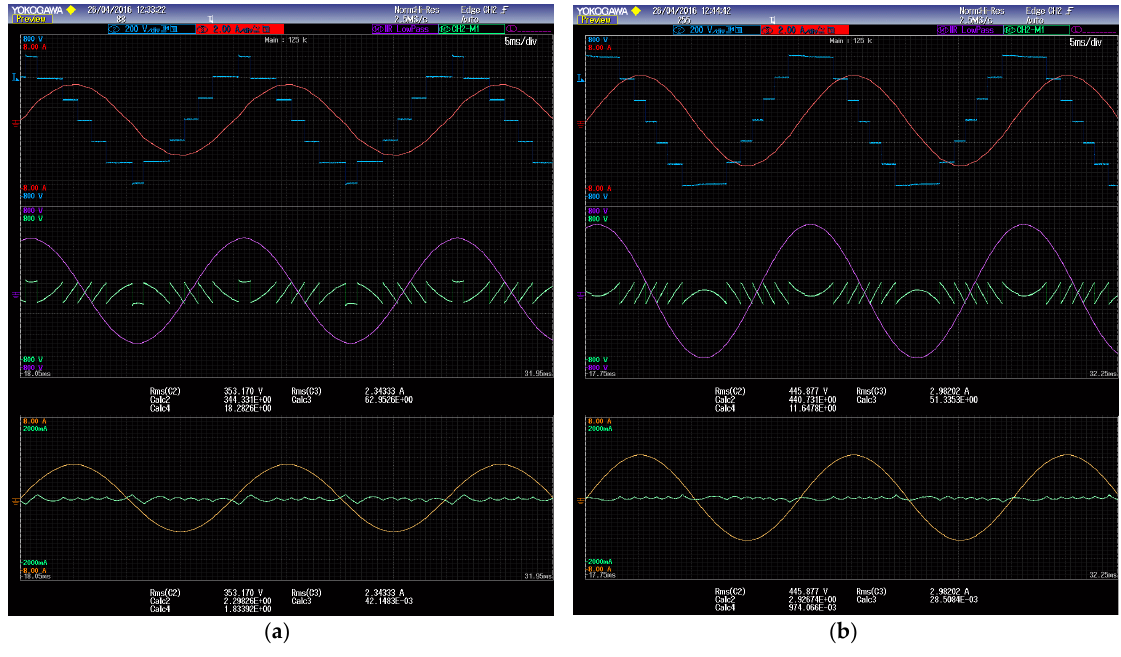
Figure 15. Minimized voltage and current THD s (Figure 12): ( a ) m = 2.49 ( α 1 = 0.202, α 2 = 0.633, α 3 = 1.397); and ( b ) m = 3.14 ( α 1 = 0.160, α 2 = 0.495, α 3 = 0.925).